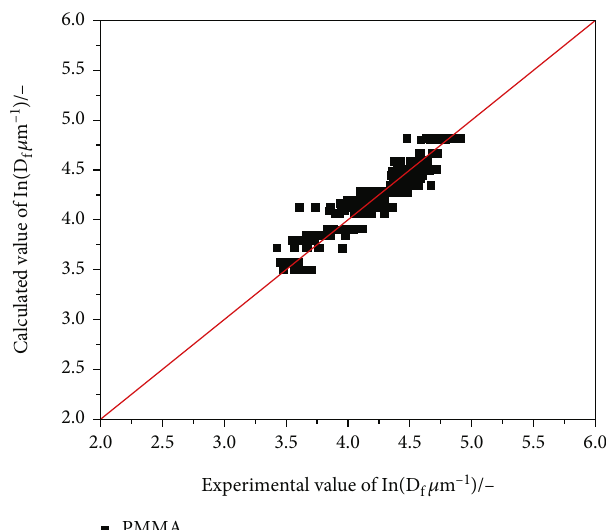
Figure 7: Comparison of the calculated fi bre diameters utilising the linear regression model with the experimental measurements for PMMA 6N and 7N.